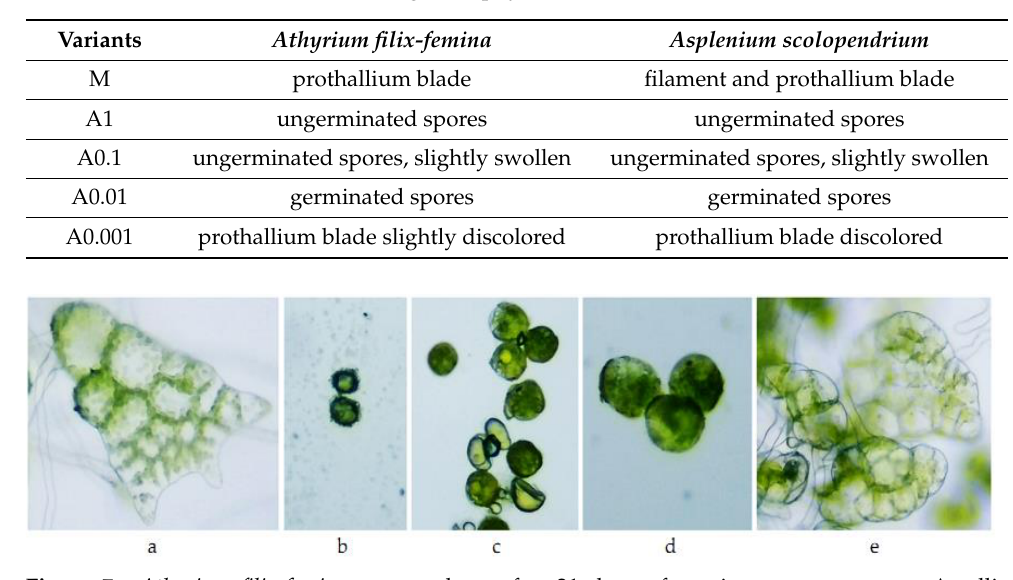
Figure 7. Athyrium filix-femina gametophyte after 21 days of continuous exposure to Actellic 50 EC: ( a ) C (100 × ) — prothallium blade; ( b ) A1 (100 × ) — ungerminated spores; ( c ) A0.1 (100 × ) — ungerminated spores, slightly swollen; ( d ) A0.01 (100 × ) — germinated spores; and ( e ) A0.001 (100 × ) — prothallium blade.